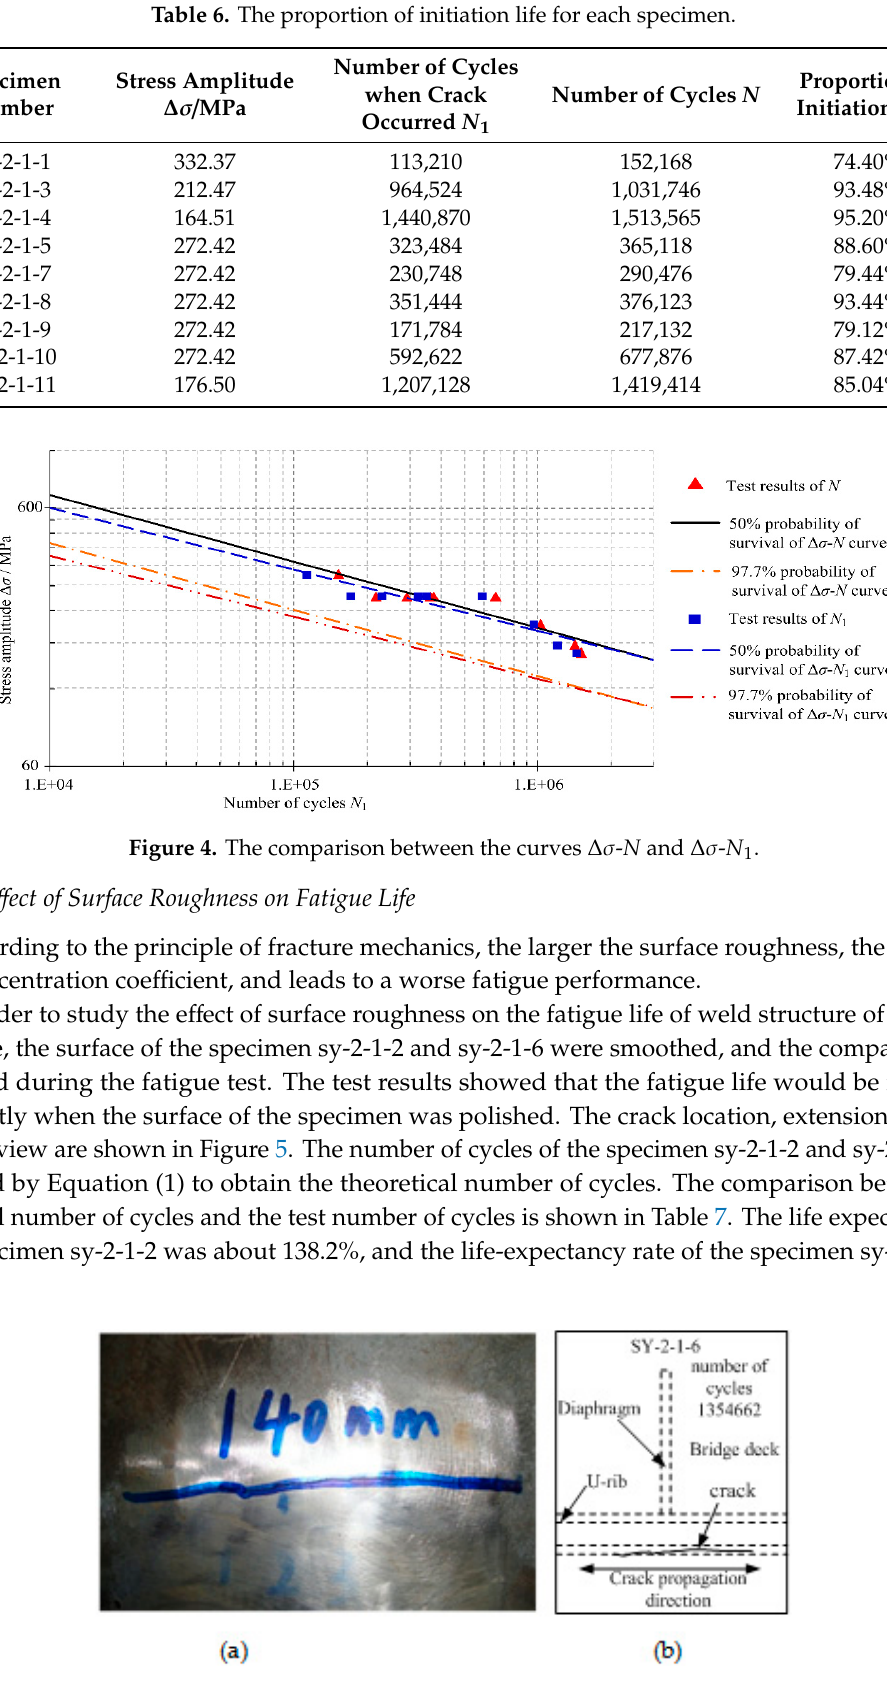
Figure 5. The crack of the specimen SY-2-1-6: ( a ) Crack of the specimen; and ( b ) position of the crack.